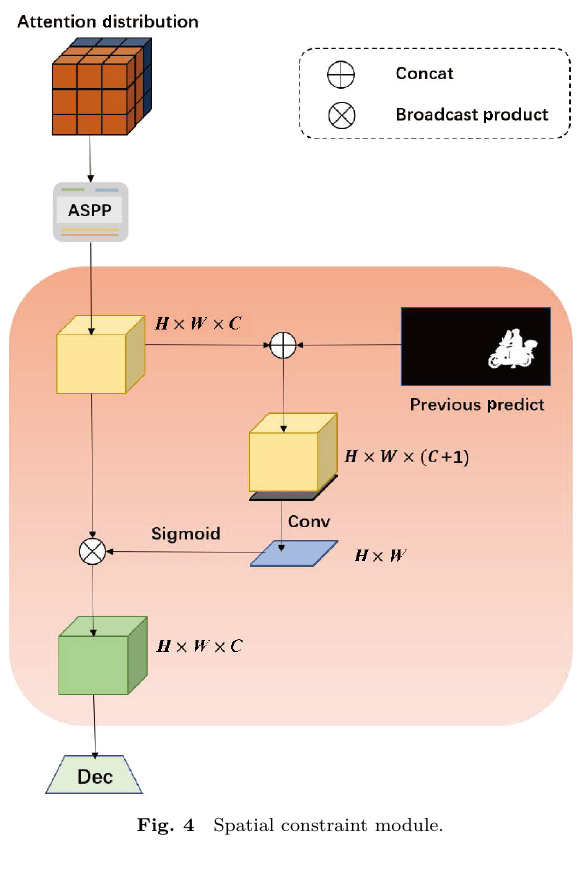
Fig. 4 Spatial constraint module.